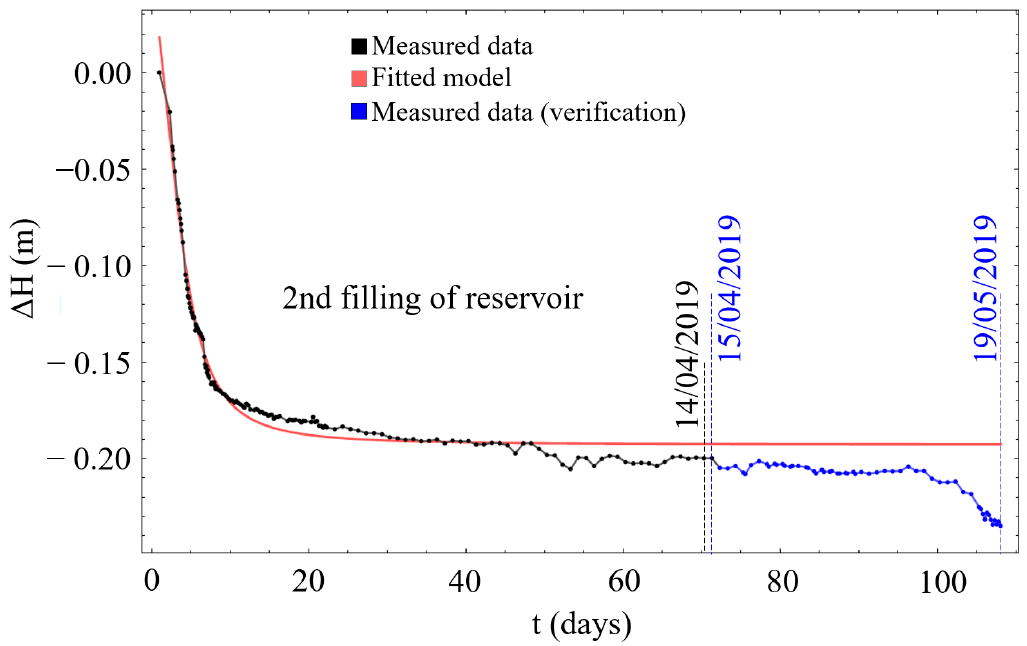
Figure 20. Visual presentation of future settlement prediction for point MG19; settlement data used for fitting (black), fitted FNSE model (red) and verification settlement data (blue).